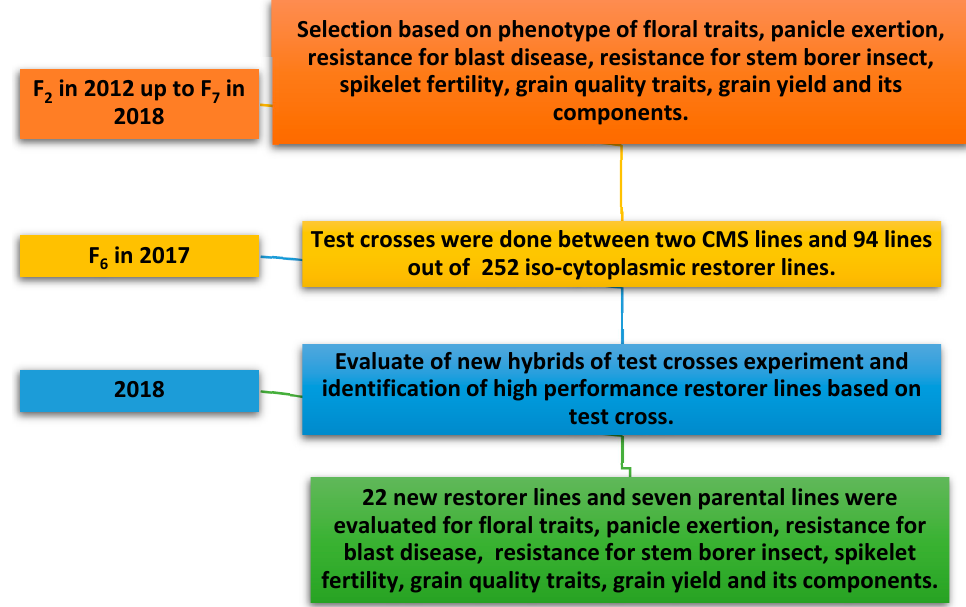
Figure 1. Breeding scheme illustrating the development of 22 promising new iso-cytoplasmic restorer lines in rice through the Rice Breeding Program, Rice Research Section, Field Crops Research Institute, Agricultural Research Center, Giza, Egypt.